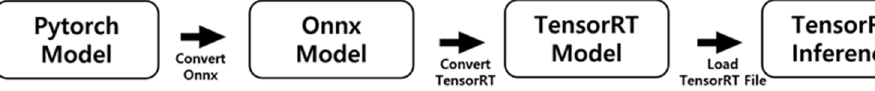
Figure 6. TensorRT conversion process.